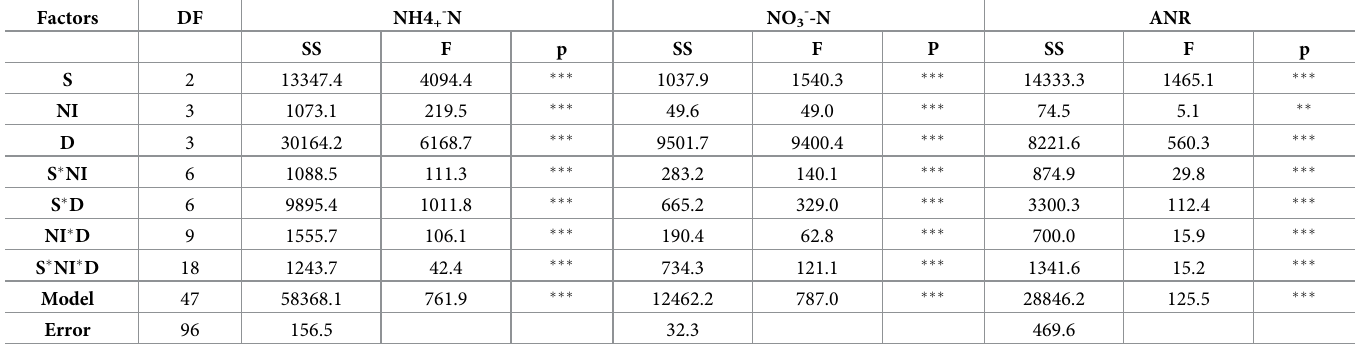
Table 2. Three-way ANOVA ( P < 0.05) of soil types (S), nitrification inhibitor (NI) and days after planting (D) and their interactions ((S � NI), (S � D), (NI � D) and (S � NI � D)) on the content of NH4+-N, NO3—N and apparent nitrification rate (ANR). Factors